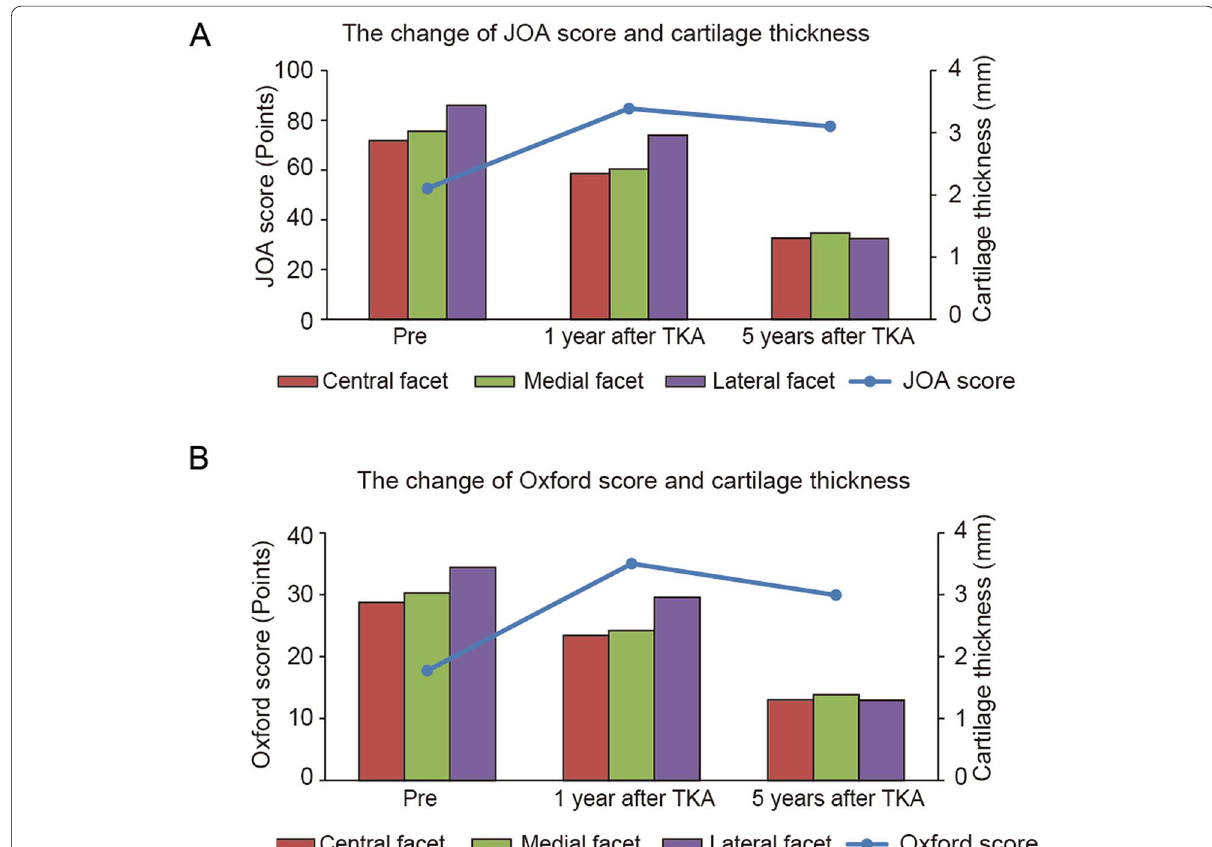
Fig. 5 Comparative changes in cartilage thickness and functional knee score before surgery and at 1 and 5 years after TKA. The change in cartilage thickness of the patella (central, medial, and lateral facets) and ( A ) JOA score and ( B ) Oxford knee score before surgery and at 1 and 5 years after TKA. JOA score, Japanese Orthopedic Association score; TKA, total knee